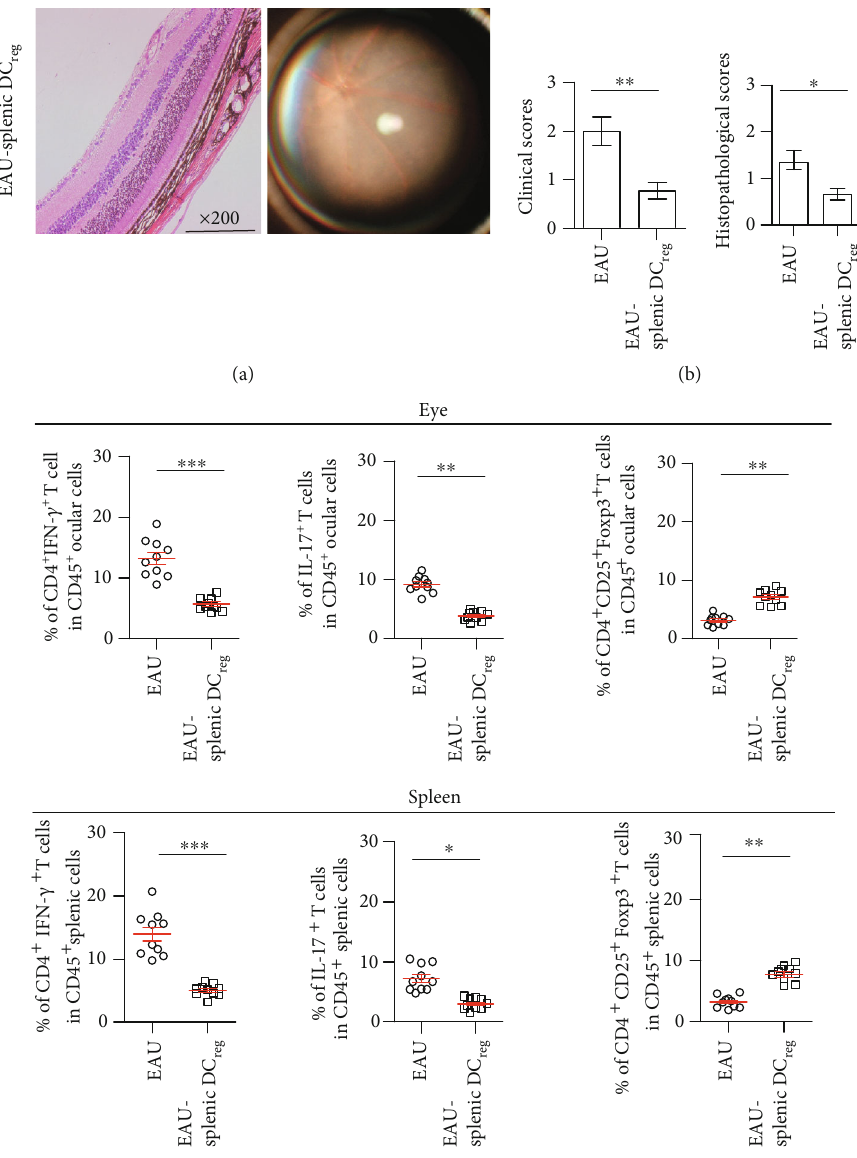
Figure 4: DC isolated from the spleen of EAU decreased the symptom of EAU. DC reg transferred into the mice, which were immunized for 8d. After 8d of transferring, the symptom of the eyes was determined by ophthalmoscopy, and the eyes of those mice were obtained and were detected by H&E (a). Clinical scores and histopathological scores were analyzed (b). (c) The percentage of CD4 + IFN- γ + T cells, CD4 + CD25 + Foxp3 + , or CD4 + IL-17 + T cells in the eyes or spleen of -transferred EAU mice compared with those without transfer. ( n = 10 /group, experiments were replicated three times, splenic DC reg data were presented as mean ± standard error of the mean (SEM), two-tailed Student ’ s t -test was conducted, and ∗ P < 0 : 05 , ∗∗ P < 0 : 01 , and ∗∗∗ P < 0 : 001